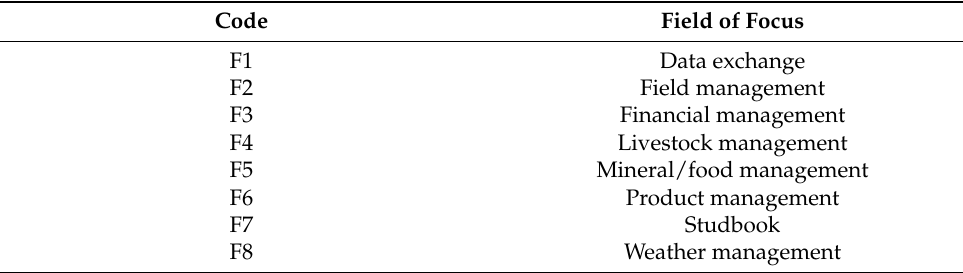
Table 4. Codes for the specified fields of focus for an FMIS.